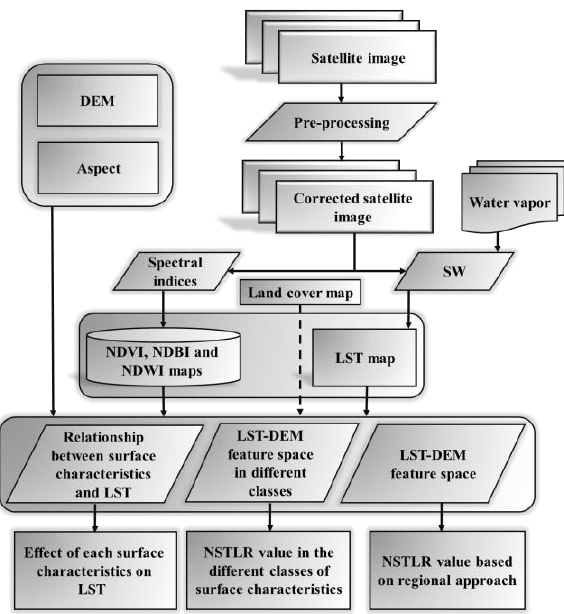
Figure 2. Flow diagram showing the analytical steps adopted in this study